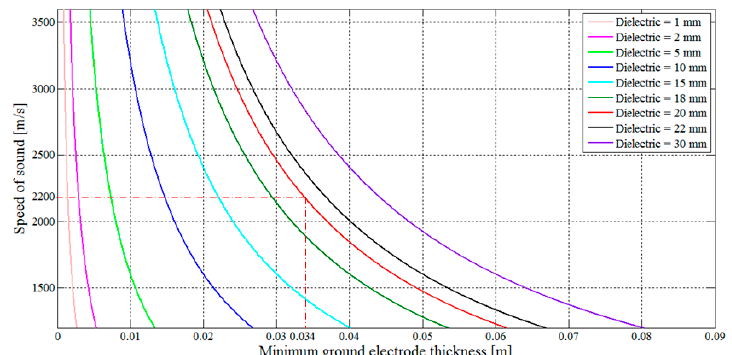
Figure 9. Abacus for the choice of the minimum ground electrode thickness needed to avoid reflections in the main output signal. The red dotted line highlights our case in which the dielectric layer made of XLPE material have sound velocity of 2200 m / s and thickness 20 mm.